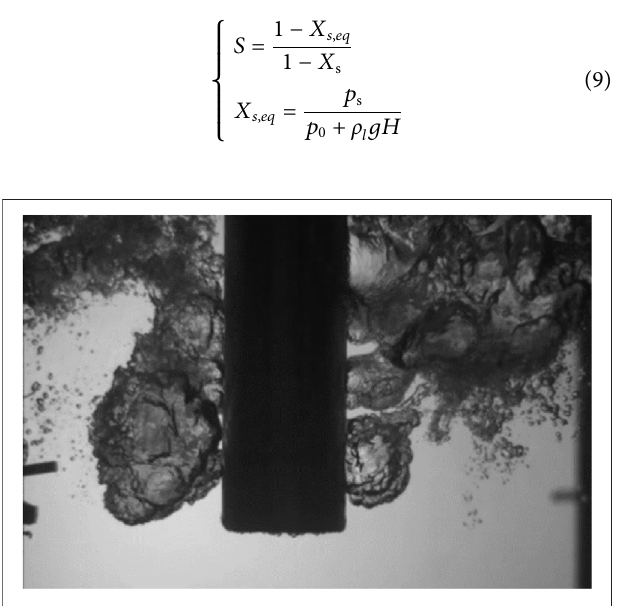
FIGURE 5 | Bubble fl ow image at 41 kg/m 2 s (D 0 =1 cm, X m